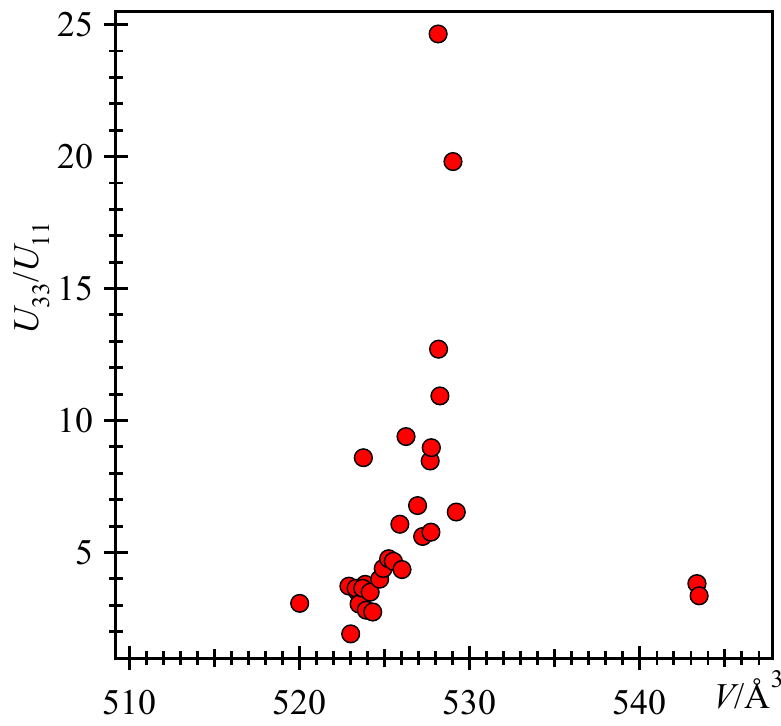
Figure 10. The U 33 / U 11 ratio of the F/Cl/OH atom with V for some of our Ap samples. For F-Ap samples, a large increase in U 33 / U 11 ratio indicates possible positional disorder of the F atom from the z = 1 / 4 mirror plane, or disorder of the F and OH as their positions are close to each other. Cl-Ap and many of the other samples have normal U 33 / U 11 ratios.